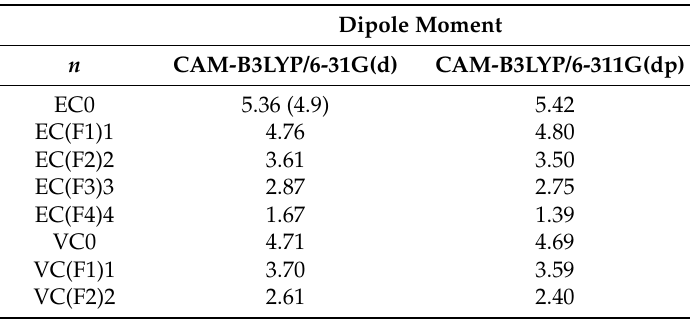
Table 1. Dipole moments of EC, EC(F), VC and VC(F) (in Debye). The number of fluorine atoms in EC is denoted by n . The experimental value of the dipole moment is given in parenthesis [17]. CAM, Coulomb-attenuating method.